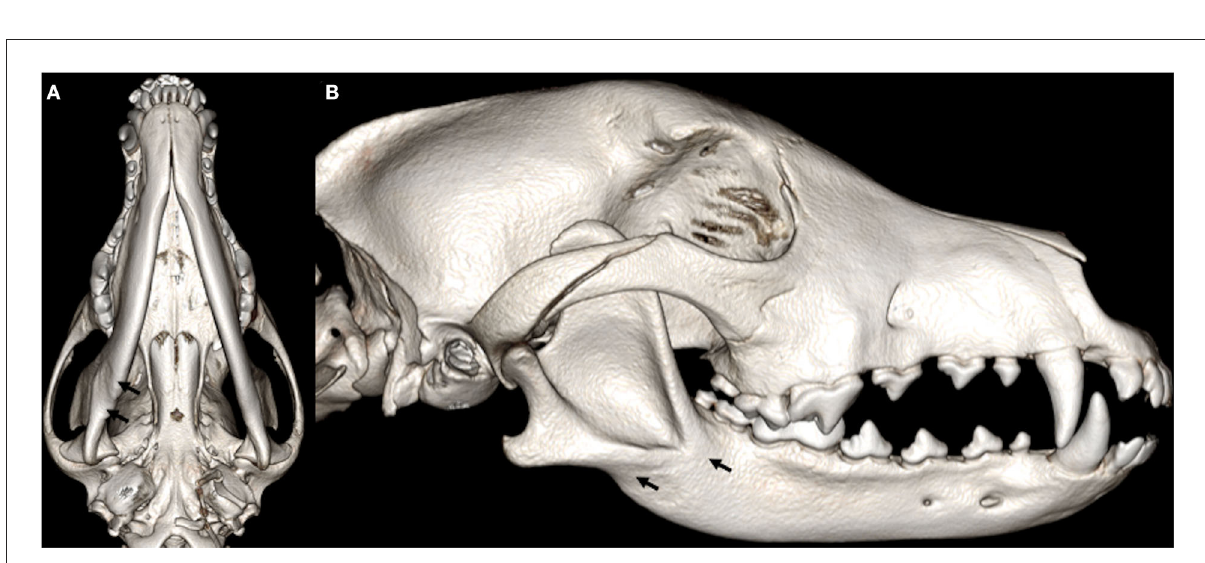
FIGURE4 Three-month follow-up: 3D-rendered ventral (A) and right lateral (B) CBCT images of the skull of the same dog as in Figure 3. The previously described fracture exhibits satisfactory healing with bridging bone formation, callus, and is actively remodeling (arrows).